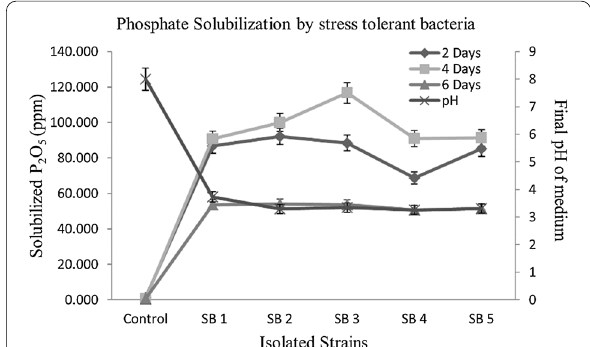
Fig. 3 Comparison of different types of stress-tolerant phosphate solubilizing bacteria by insoluble tri-calcium phosphate. Results represented as mean SD (n ± =